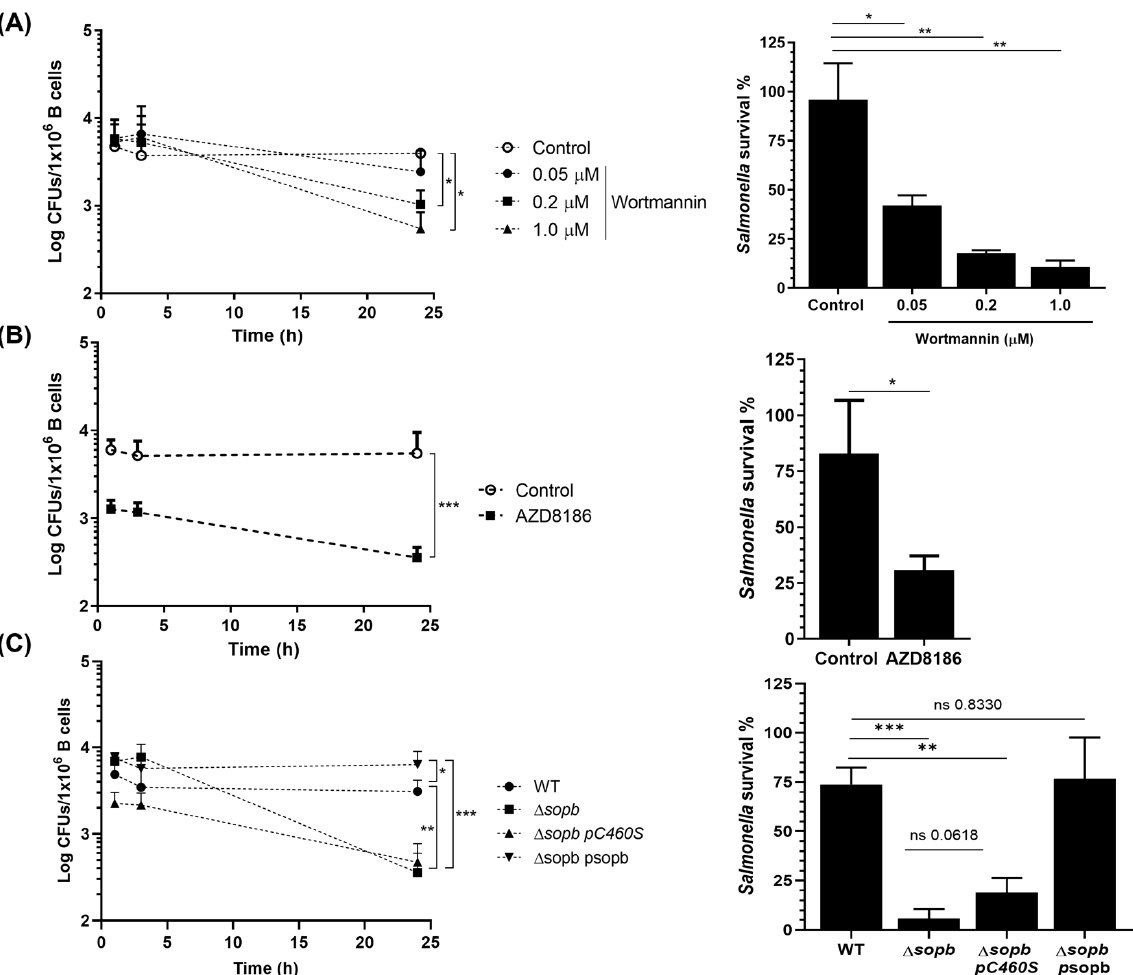
Figure 1. Class-I PI3K is needed for Salmonella survival in B cells. B cells were purified from the spleens of C57BL/6 mice and infected at a MOI of 50 with Salmonella . Subsequently, the cells were lysed and plated on LB Agar at the indicated times. ( A ) CFUs were recovered from infected B cells and treated 1 h before and during infection with the indicated concentrations of wortmannin or ( B ) treated with the PI3K class I inhibitor AZD8186 (500 nM). ( C ) B cells were infected at a MOI of 50 with Salmonella WT, Salmonella ∆ sopb, Salmonella ∆ sopb pC460S (phosphatase-inactive domain), or Salmonella ∆ sopb psopb (WT SopB). Percentage of Salmonella survival in ( A – C ) was calculated by dividing CFUs recovered at 24 h between CFUs recovered at 1 h. Results are expressed as means ± SDs. n = 3. A two-way ANOVA test was used for multiple comparisons, and an unpaired Student’s t -test was used for bars. * p < 0.05, ** p < 0.01, and *** p < 0.001.